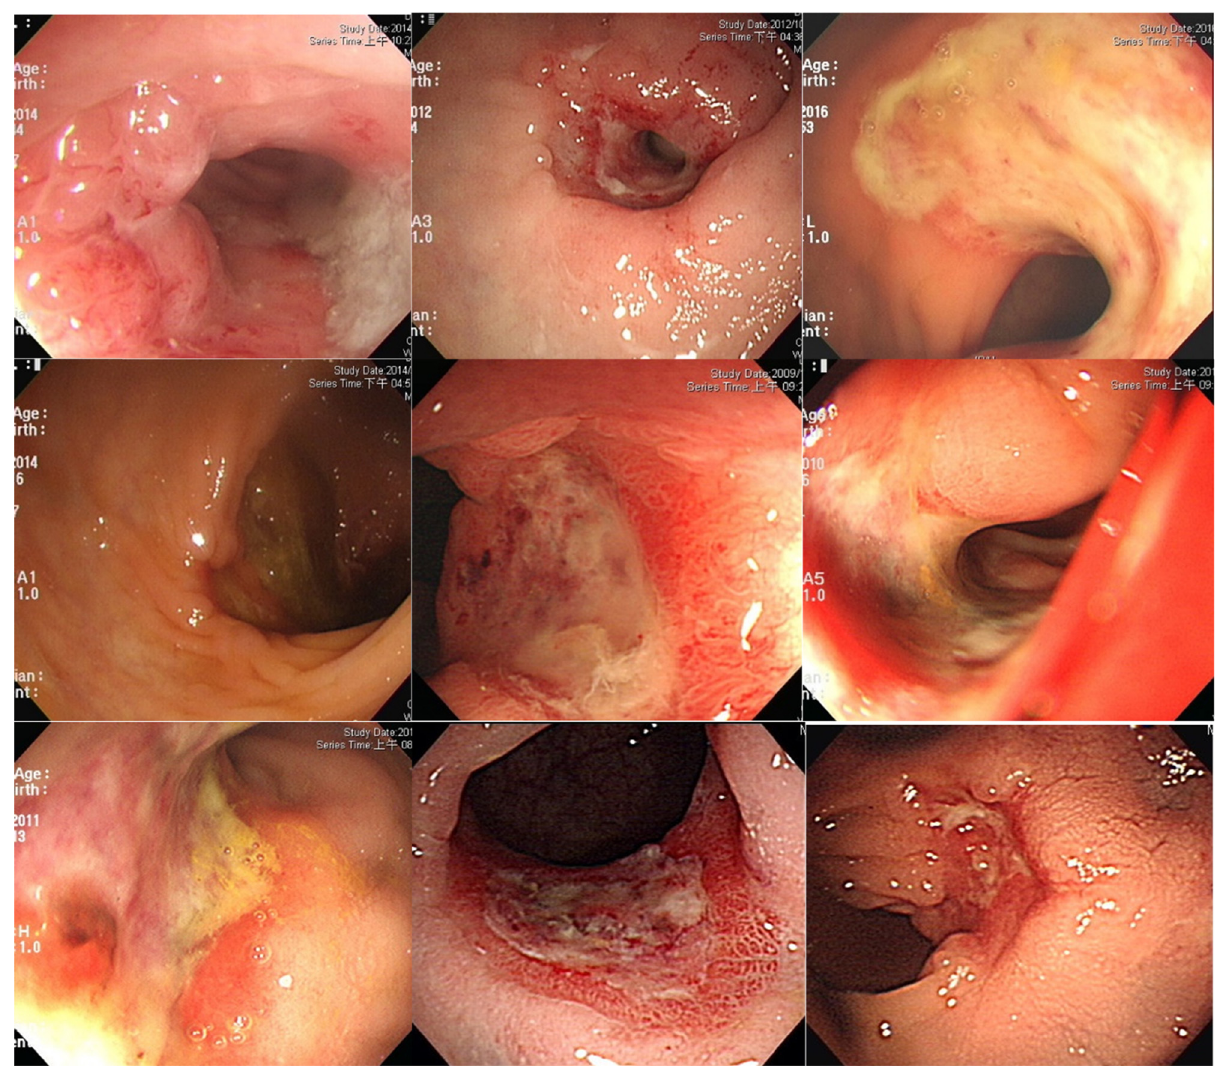
Figure 3: Colonoscopy fi ndings of patients in the RR group who did not achieve